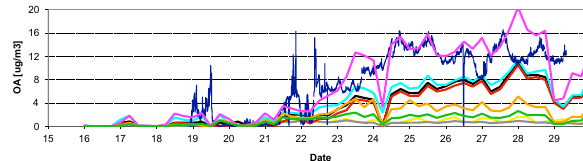
Fig. 4. AMS-measured (dark blue line) and modelled near-surface SOA mass concentration during June 2010 at Puy-de-Dôme, France. Grey line: according to Anttila et al. (2010); yellow line: more VOC precursor gases; green line: SOG transport and re- moval; orange line: SOG transport and removal plus biogenic emis- sions × 5; red line: 1. aging SOG – 1% aging; black line: 2. aging SOG – 1% aging, light blue line: 2. aging SOG – 10 % aging; ma- genta line: 2. aging SOG – 10% aging plus biogenic emissions × 5.